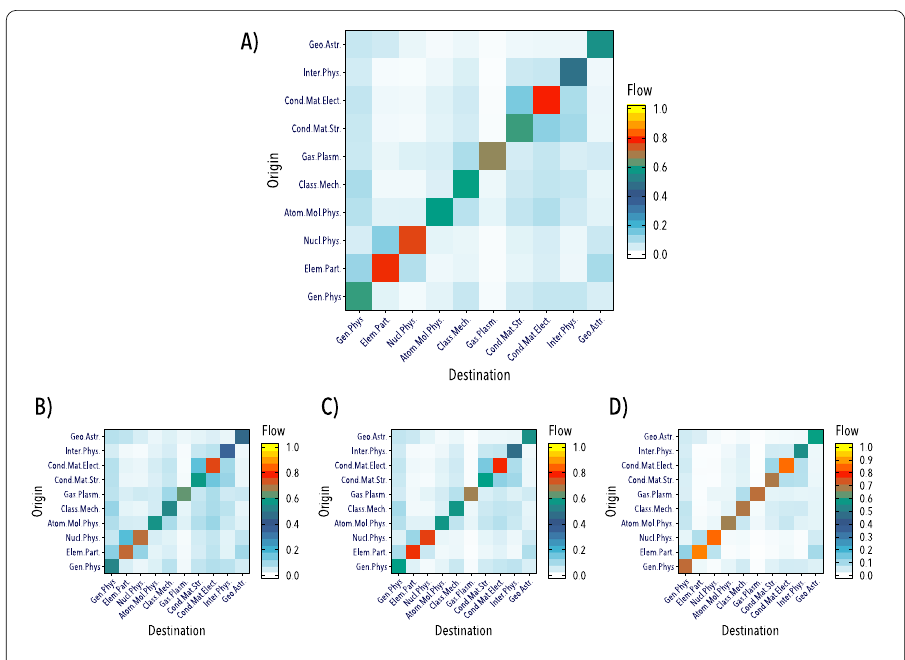
Figure 7 Interest flow across decades: ( A ) all decades; ( B ) authors who started publishing in the 80’s; ( C ) authors who started publishing in the 90’s; ( D ) authors who started publishing in the 00’s. Authors who start studying y PACS end up sharing their interest across x PACS. Each row is normalized over the number of authors who started using that PACS so that the diagonal represents the fraction of authors that kept